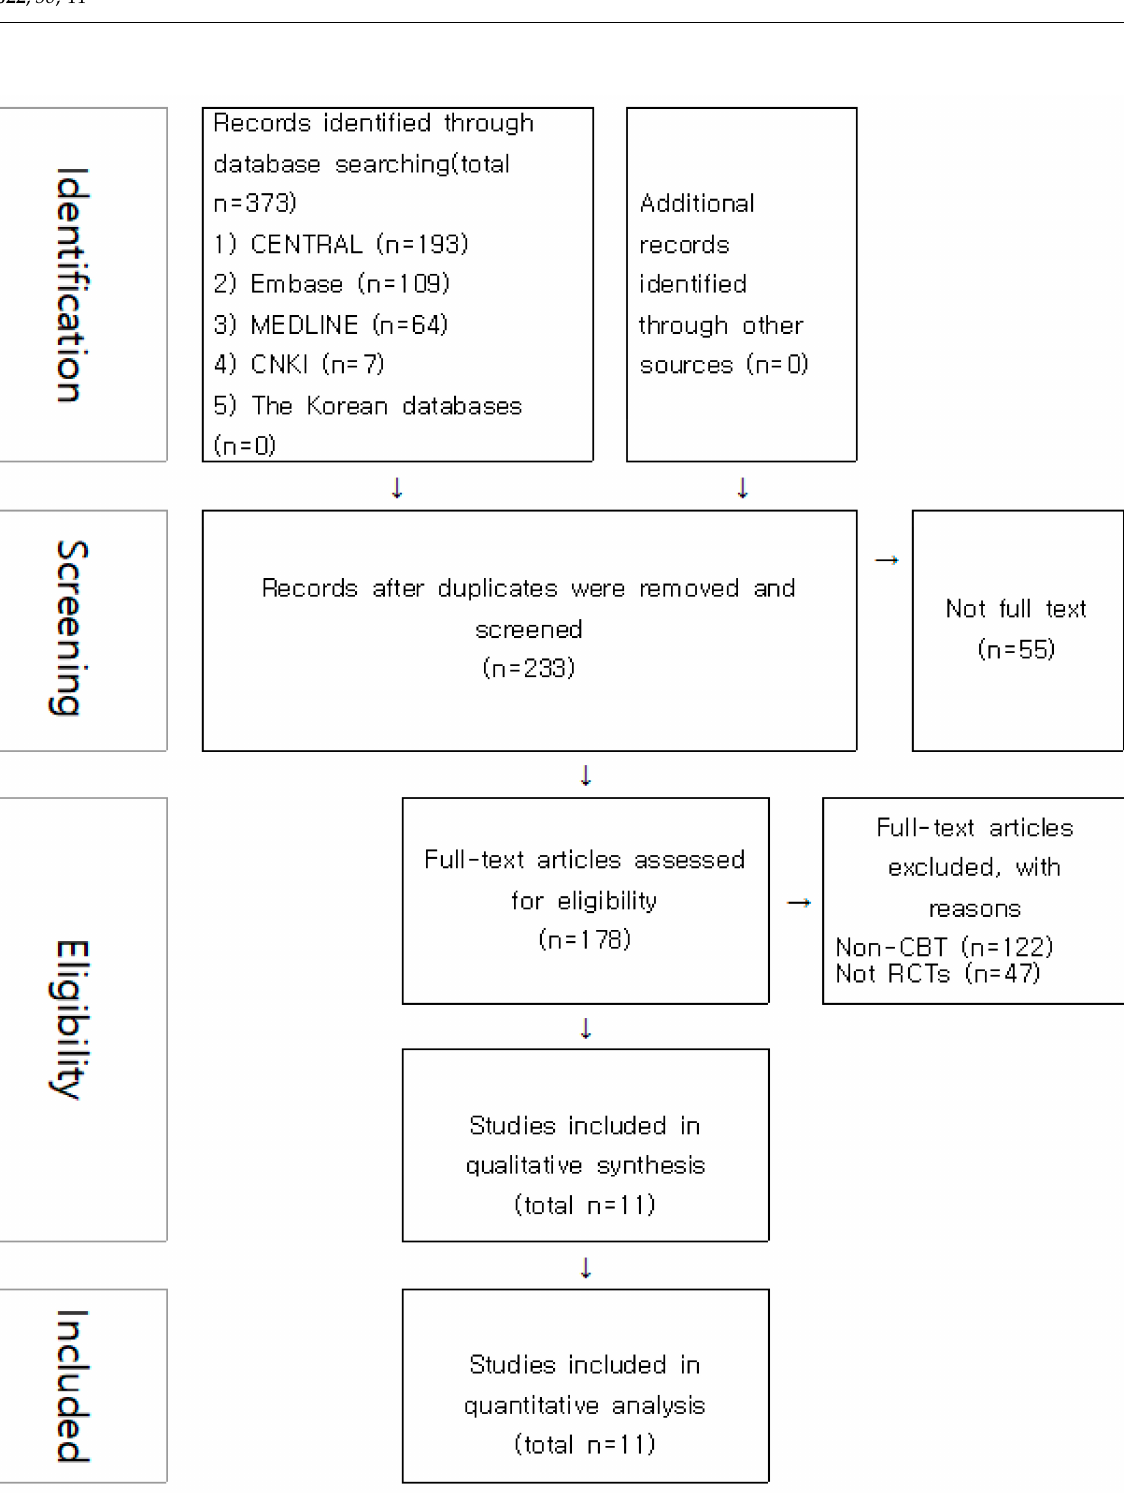
Figure 1. Scheme of the data selection process.